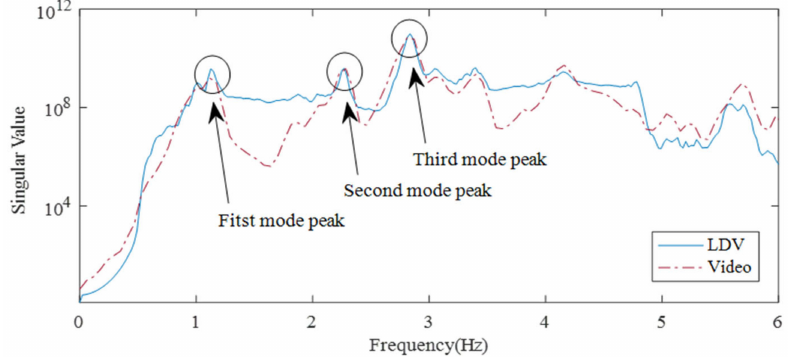
Figure 19. Singular value plot for standing wave extraction.